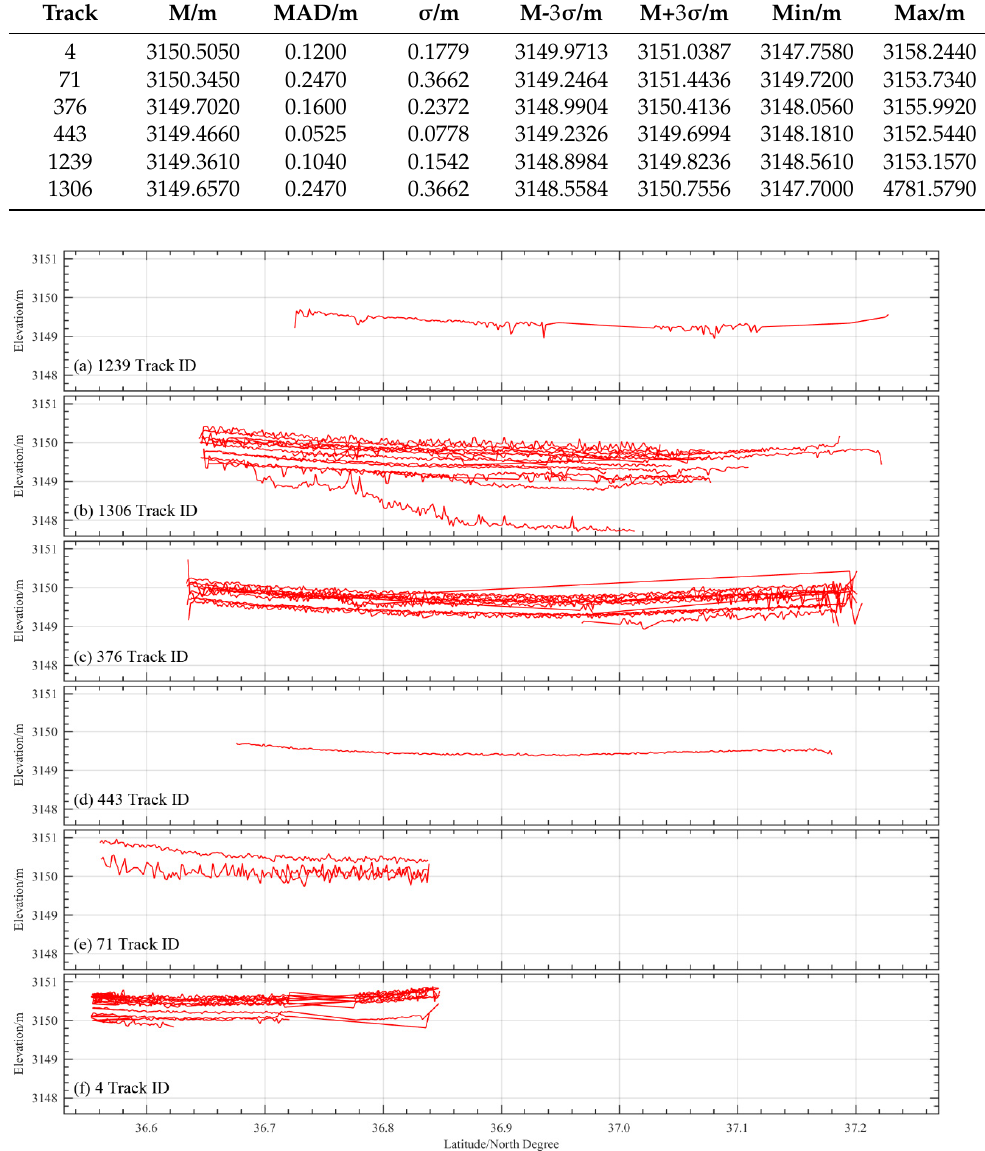
Figure 6. The elevation variation along the latitude in each track of ICESat, using the water mask boundary and the MAD outlier method.